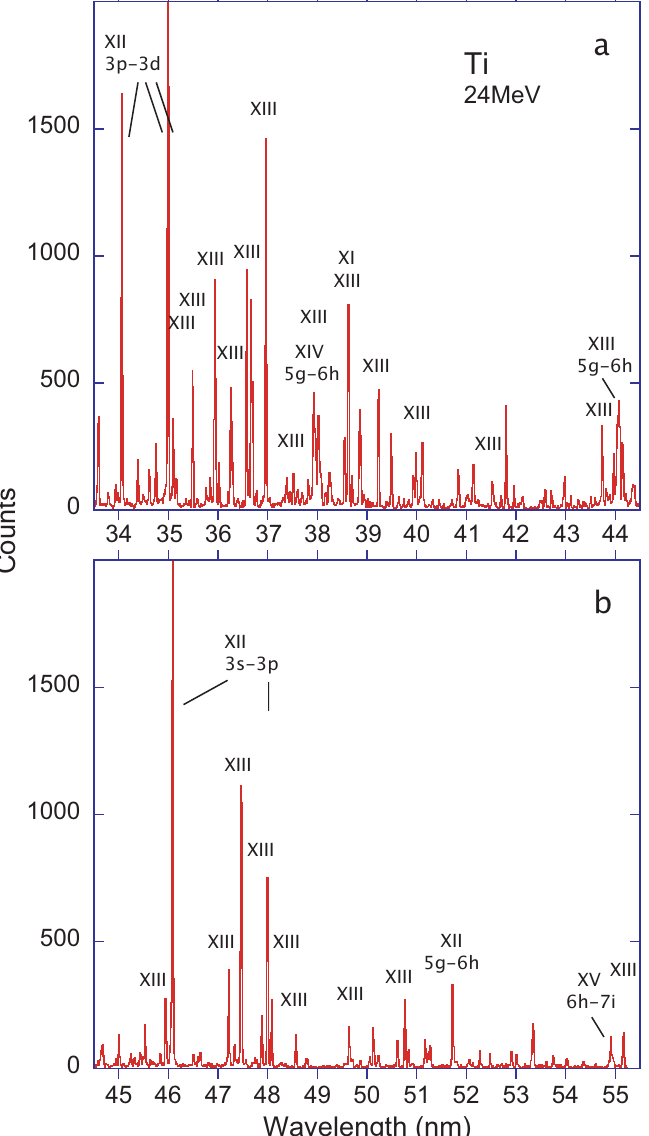
Figure 11. Two consecutive sections of a beam–foil survey spectrum of Ti, recorded at an ion beam energy of 24 MeV. ( a ) ends at a wavelength of 44.5 nm, ( b ) begins at that wavelength. Grating 600 L/mm, line width (FWHM) 0.030 nm. The strongest of the wavelength reference lines of Ne-, Na-, and Mg-like ions are identified by the spectrum number. Several yrast transition arrays are